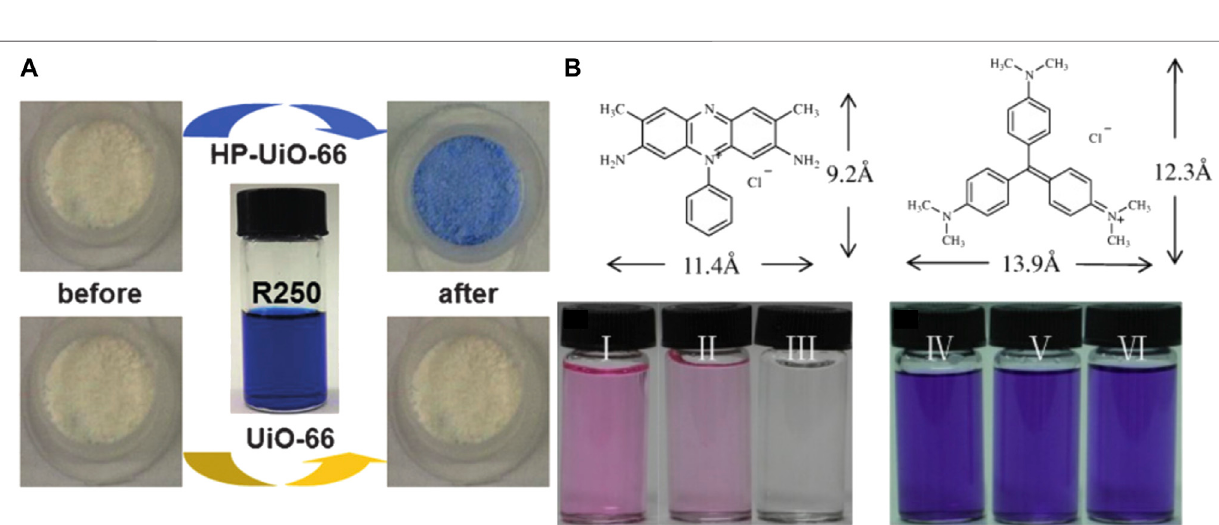
Frontiers in Chemistry |